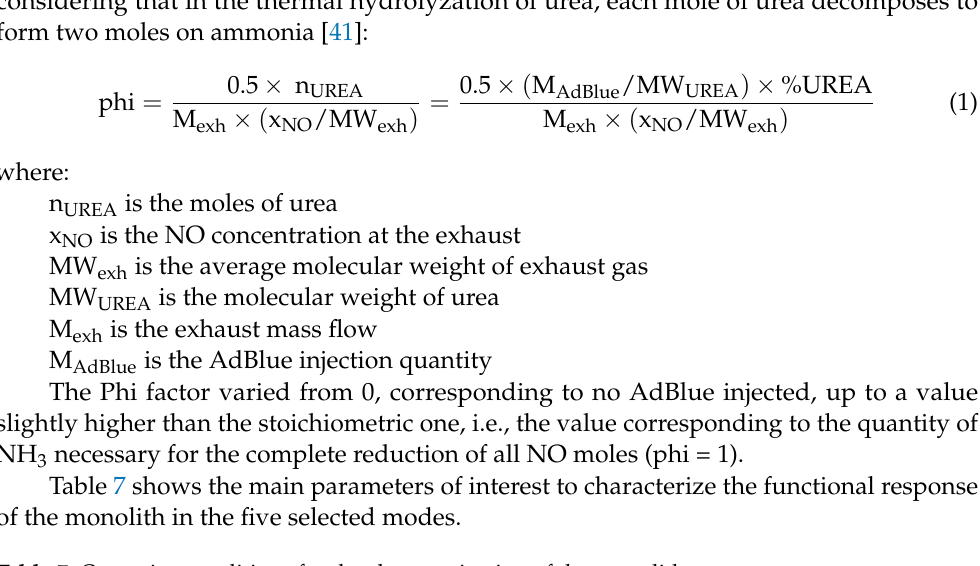
Table 7. Operating conditions for the characterization of the